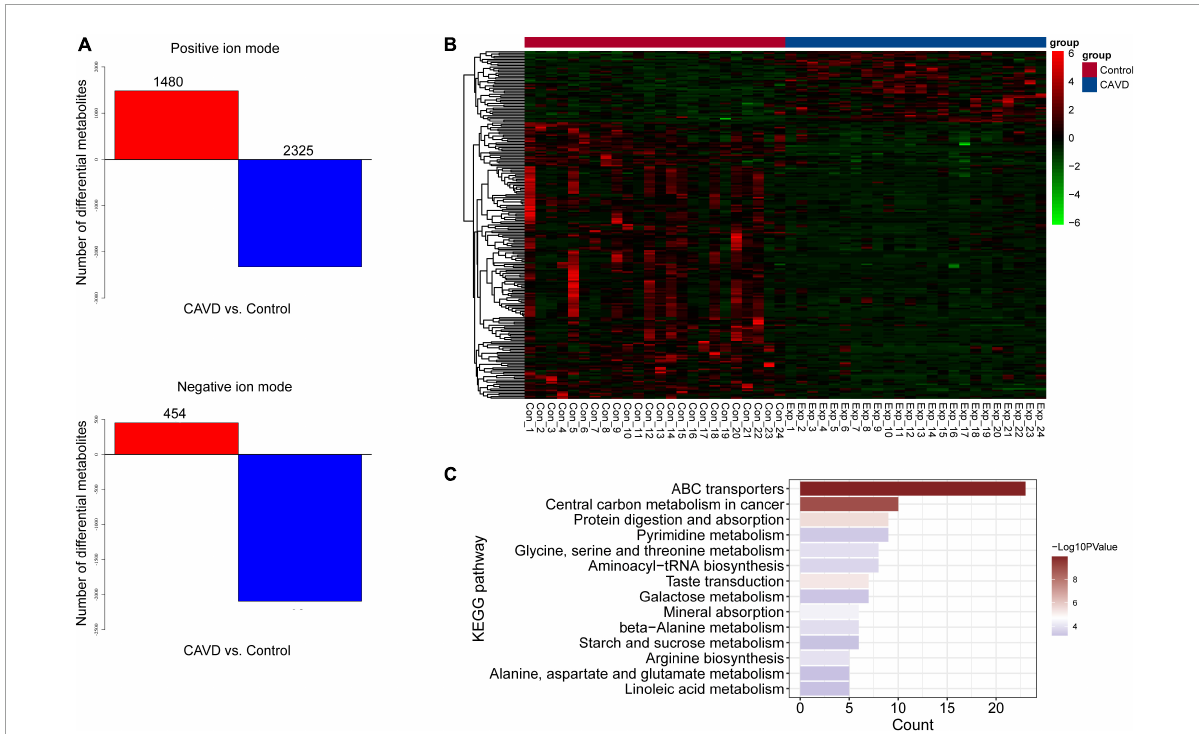
FIGURE3 Differential metabolites and identification. (A) Numbers of differential positive and negative ion metabolites. Red and blue, upregulated and downregulated metabolites, respectively. (B) Heatmap of 229 differential metabolites. (C) Significantly enriched KEGG pathways of differential